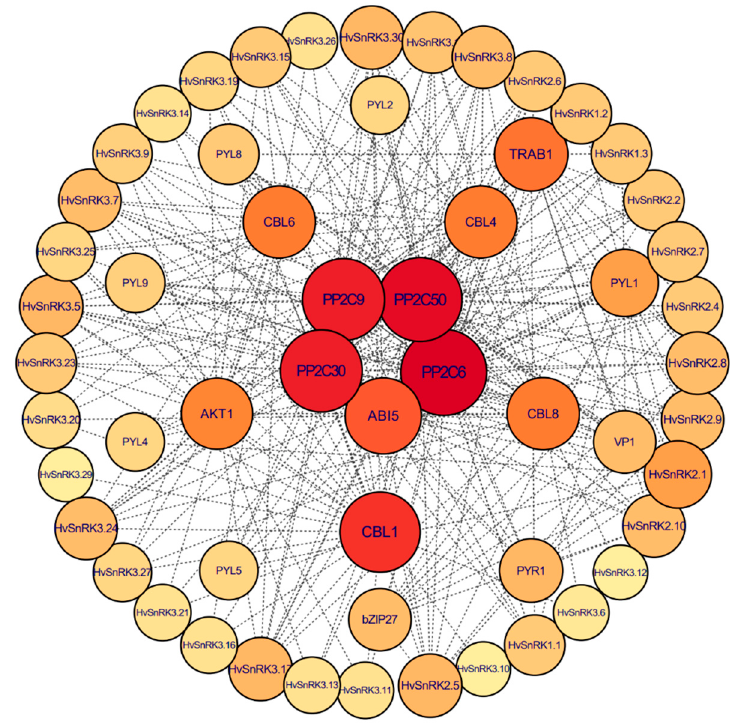
Figure 8. Predicted protein–protein interaction networks of HvSnRK proteins. The external circle represents barley SnRK proteins and the inside circles represent proteins that interact with HvSnRKs. Different layers represent phosphatase 2C family proteins, ion channel protein and PYR/PYL proteins or other transcription factor, respectively. The interaction between these proteins was represented by the gray lines which connected the four circles.